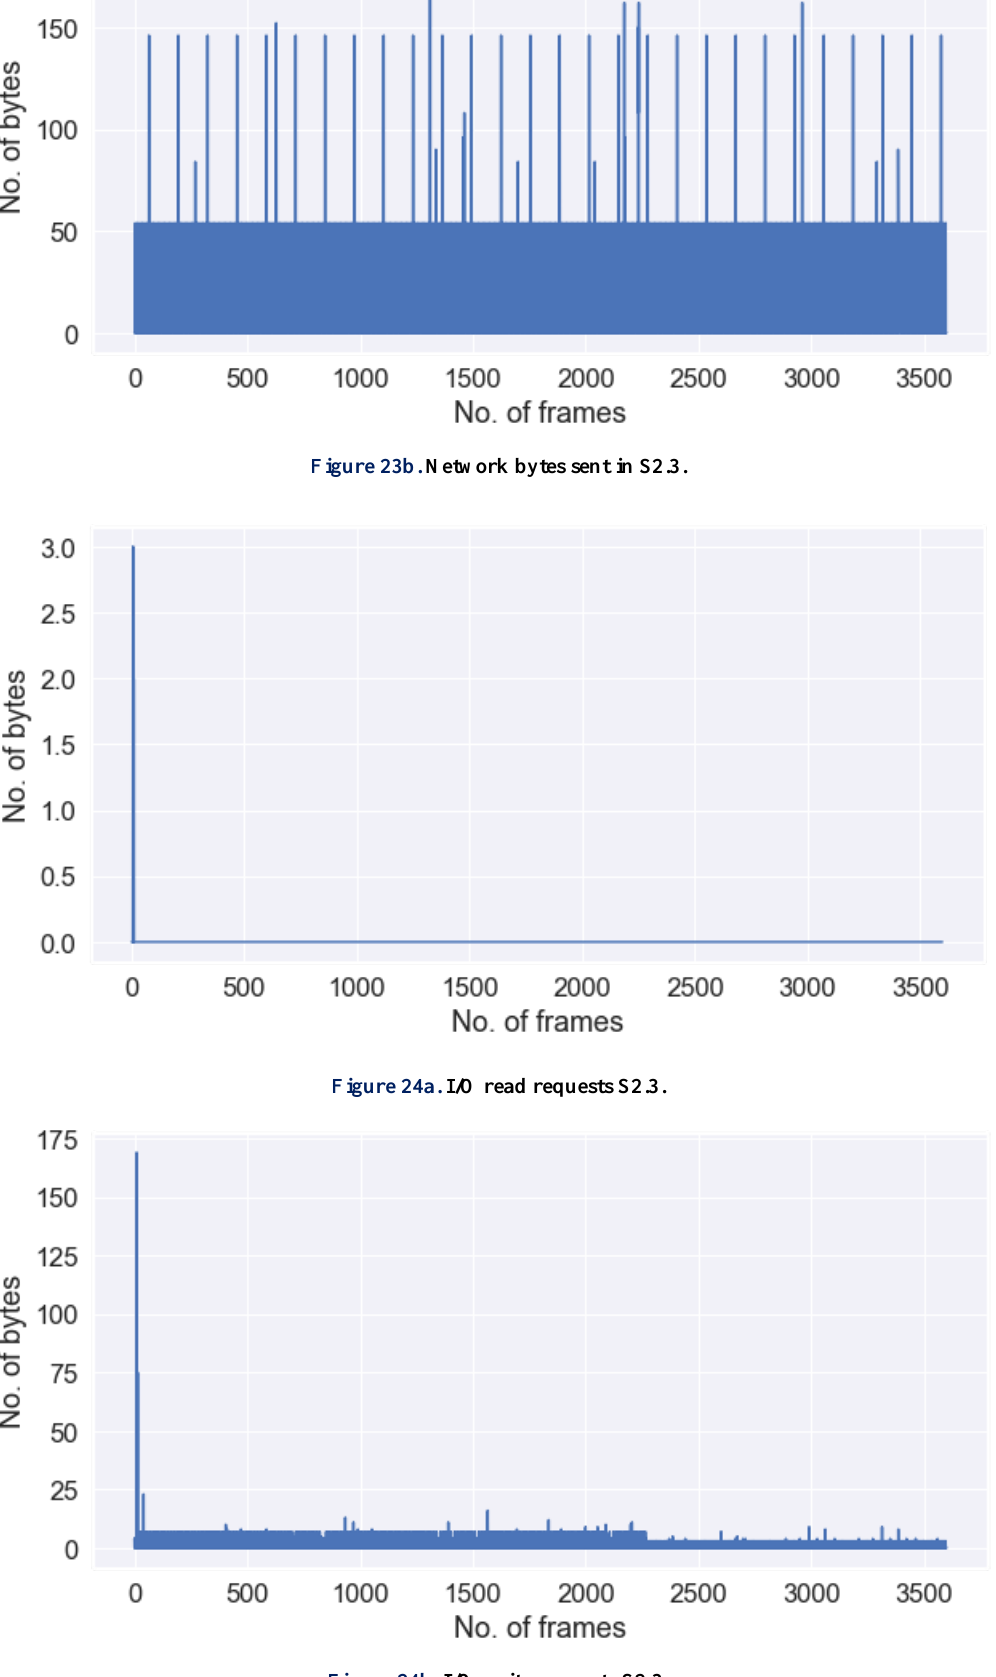
Figure 24b. I/O write requests